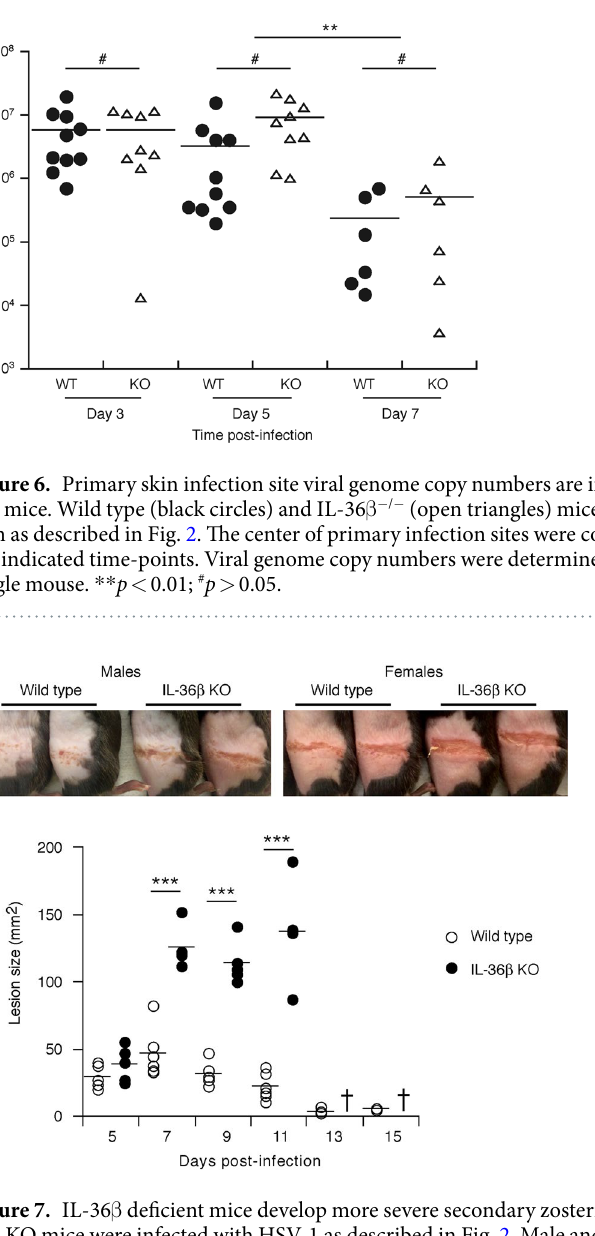
HSV-1 gD mRNA (Fig. 9d). Furthermore, the IL-36 mRNA levels remained elevated by day 7 (Fig. 9a–c), as viral levels decreased (Fig. 9d). The HSV-1 gD mRNA levels, including the observed decrease in the HSV-1 gD mRNA levels at day 7, correlate with the observed HSV-1 DNA genome copy numbers (Fig. 6). This could suggest that the induction of IL-36 expression is secondary to the infection, i.e., not a direct response to HSV-1.